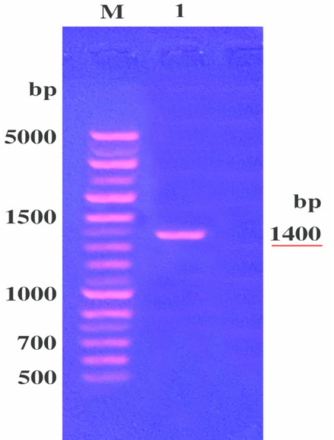
Figure 1. Agarose gel electrophoresis of amplified DNA (PCR product) obtained from 16S rRNA gene of S. aureus B3 (MRSA B3). Lane M, DNA marker of known molecular sizes; Lane 1 , PCR product of the amplified 16S r RNA gene of S. aureus B3.